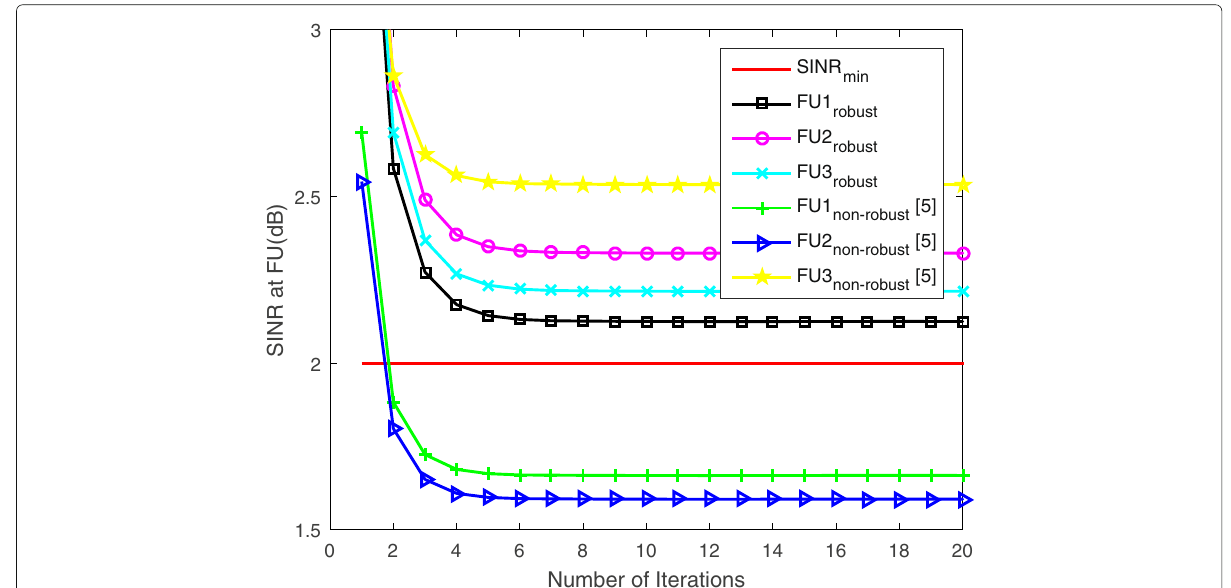
Fig. 3 Comparison of SINR received at FBS between robust and non-robust